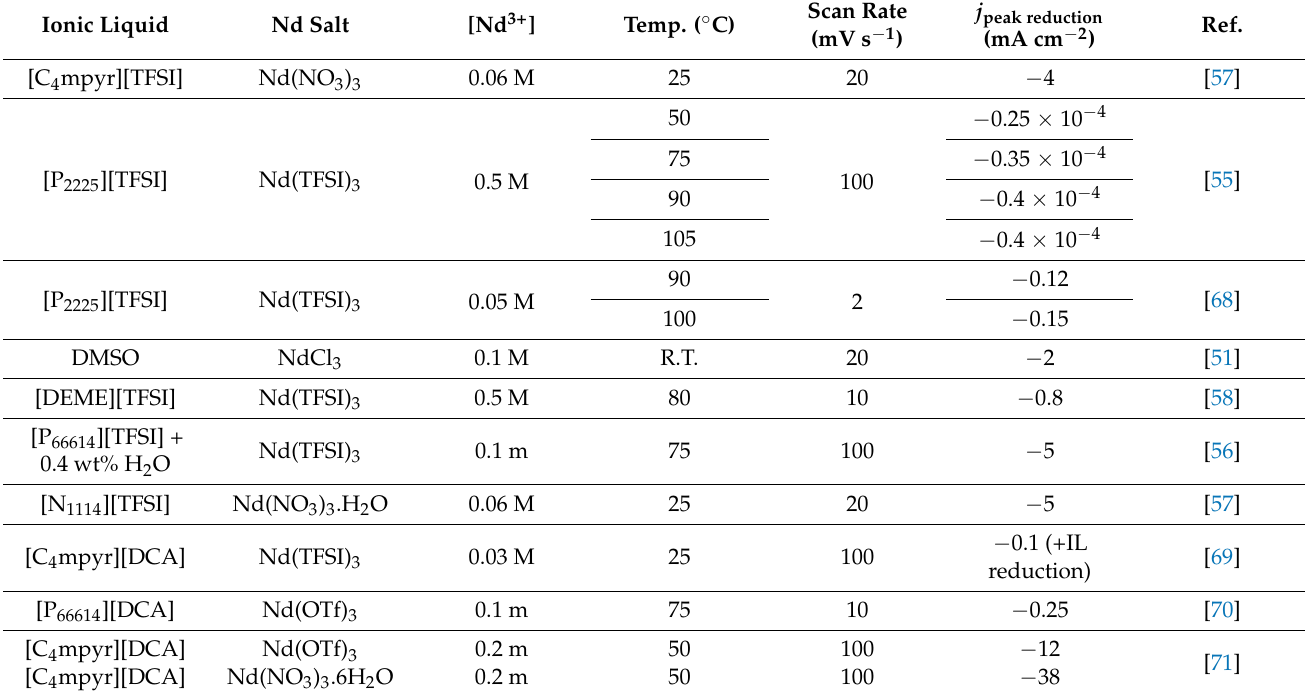
j peak reduction Scan Rate Ref. (mV s − 1 ) (mA cm − 2 )